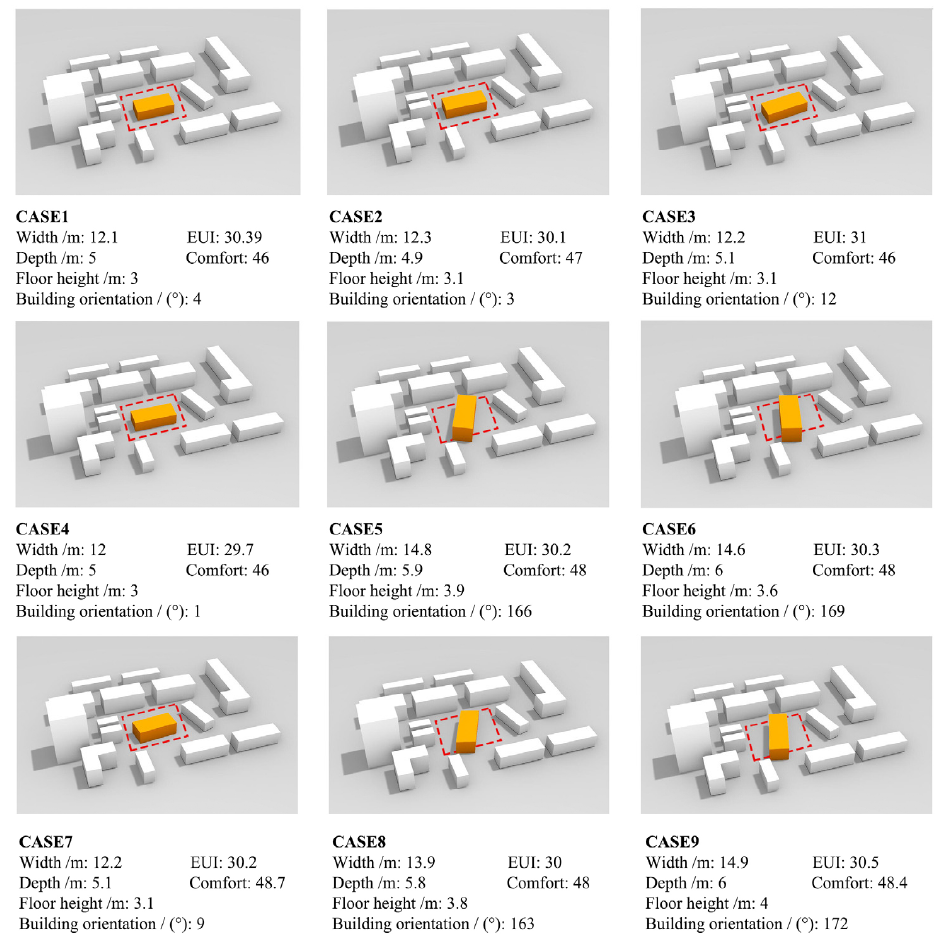
Figure 15. Building form generation case (from Pareto solution).